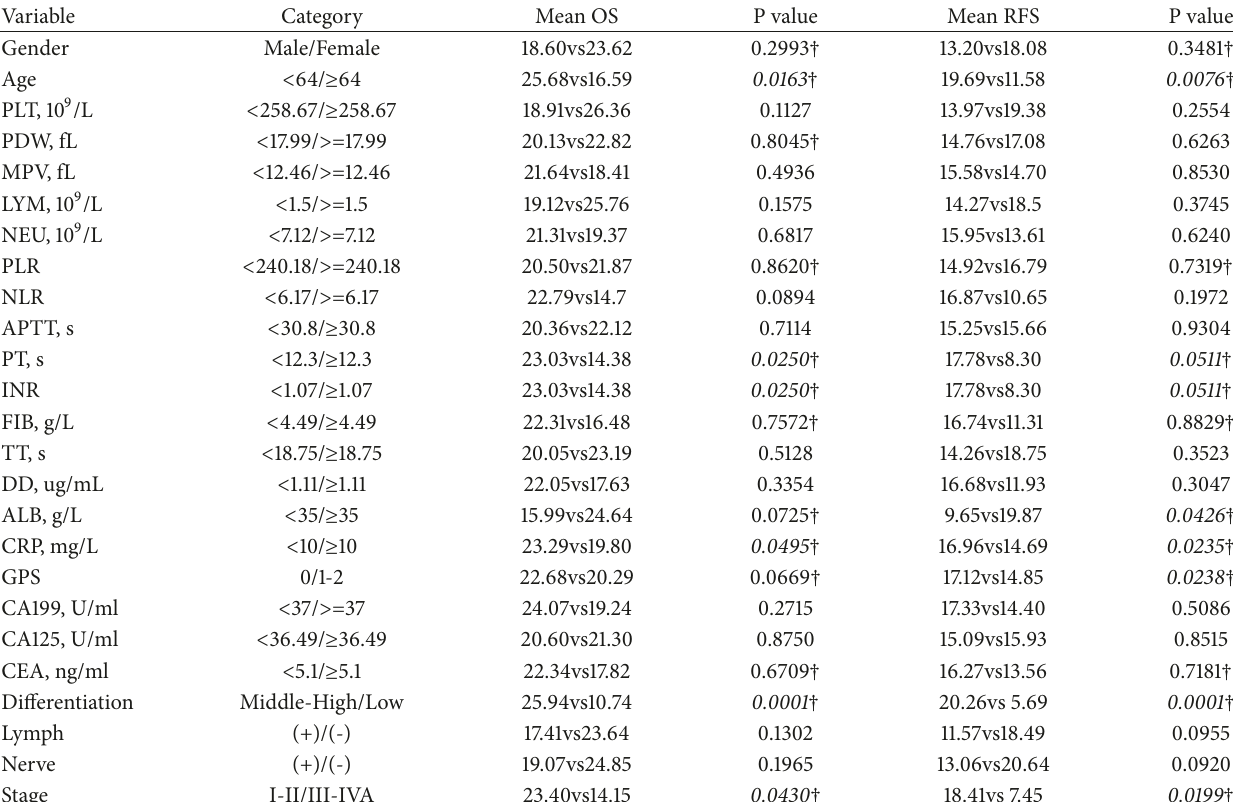
Table 4: Analysis of overall survival (OS) and recurrence-free survival (RFS) in different groups.